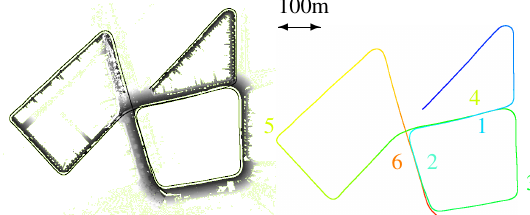
Figure 6: Trajectory fragmentation. Left: raw data, colored with respect to the distance from the MMS (low (black) → high (white)). Right: extracted polyline, colored with respect to the acquisition time (blue → red).